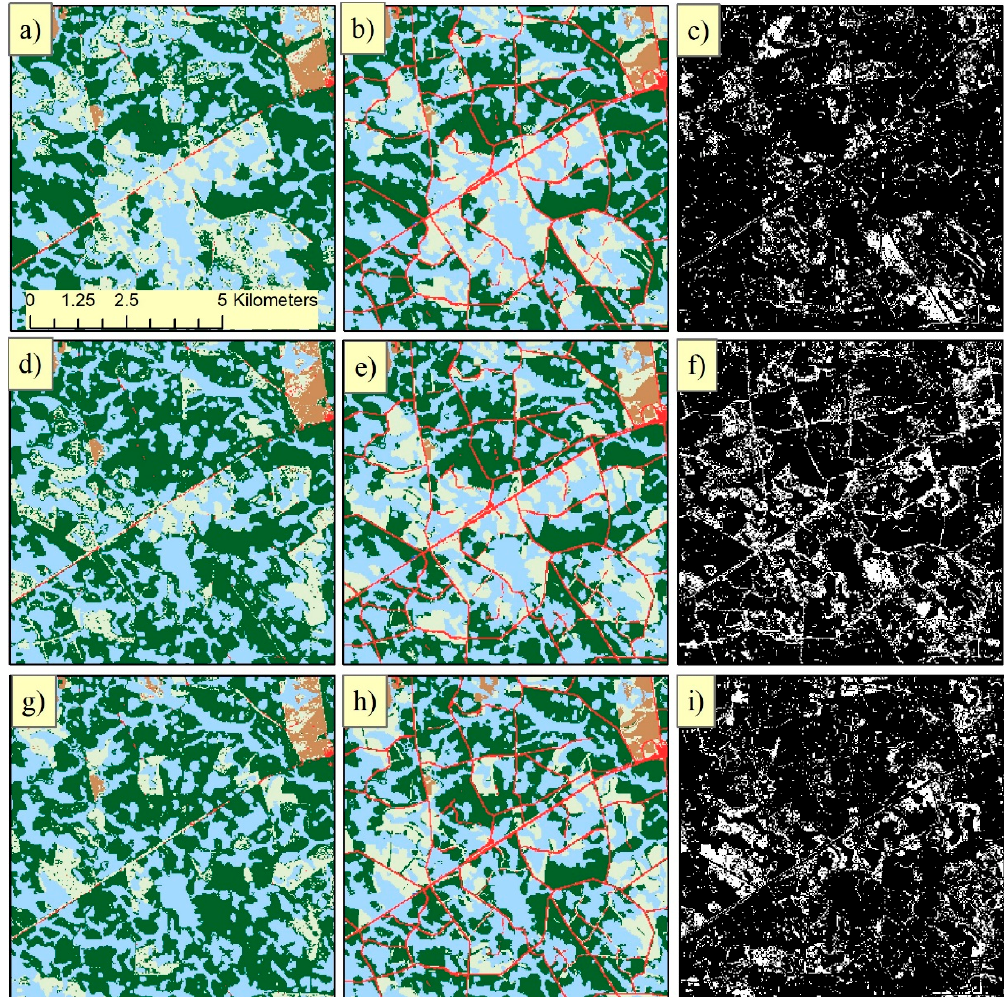
Figure 6. Example of the LCMAP and NLCD products at tile H25V15 in corresponding years: ( a ) LCMAP-2001; ( b ) NLCD-2001; ( c ) di ff erence between LCMAP and NLCD in 2001; ( d ) LCMAP-2006; ( e ) NLCD-2006; ( f ) di ff erence between LCMAP and NLCD in 2006; ( g ) LCMAP-2011; ( h ) NLCD-2011; ( i ) di ff erence between LCMAP and NLCD in 2011. The major land cover classes include Tree (green), Wetland (light blue), Grass / Shrub (yellow), Developed (red), and Cropland (brown).